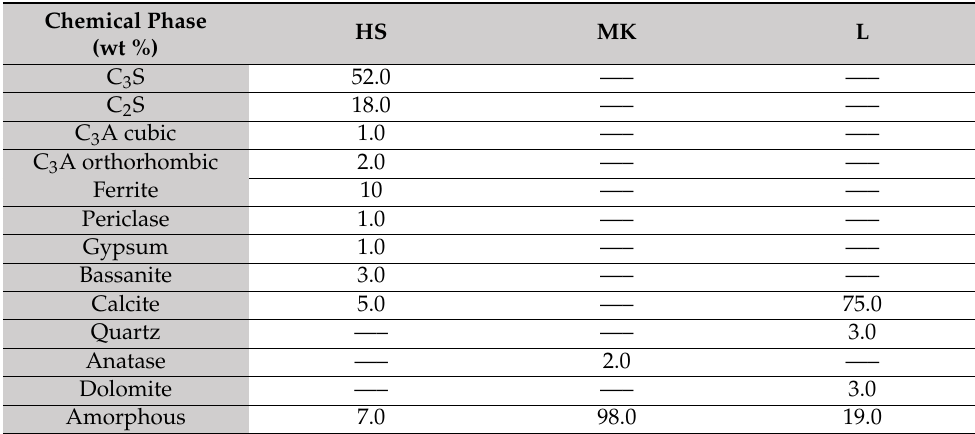
Table 2. Normalized chemical phase composition for HS, MK, Q and